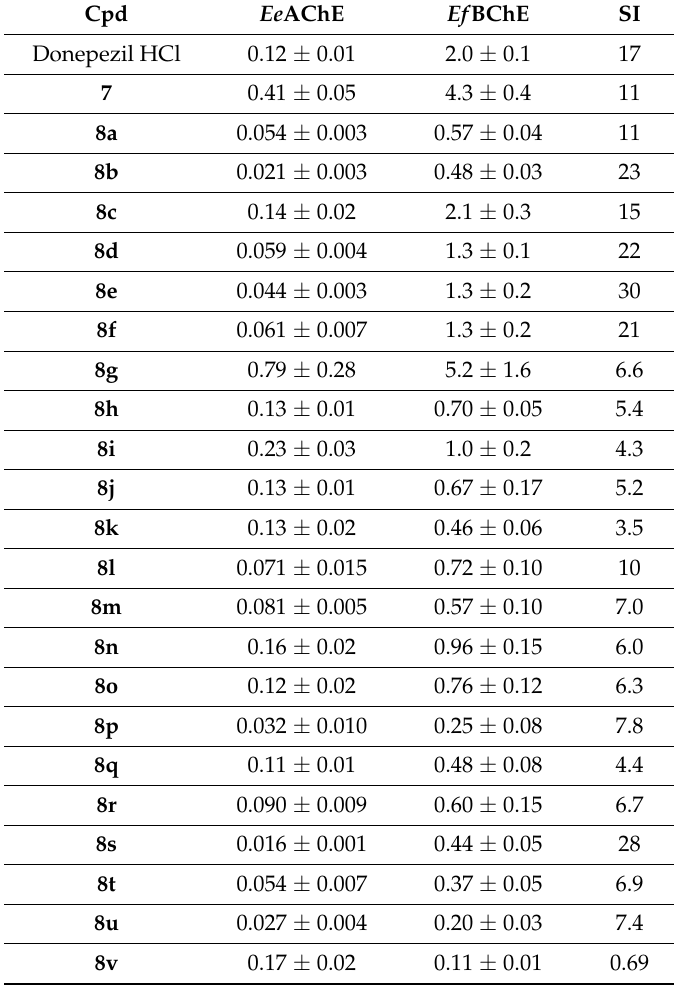
Table 1. Inhibition (IC 50 values in µ M, with standard error) of the activity of Ee AChE (from Electrophorus electricus ) and BChE (from Equus ferus ) by donepezil and its analogues 7 and 8a – v , and the selectivity index (SI) for each inhibitor based on IC 50